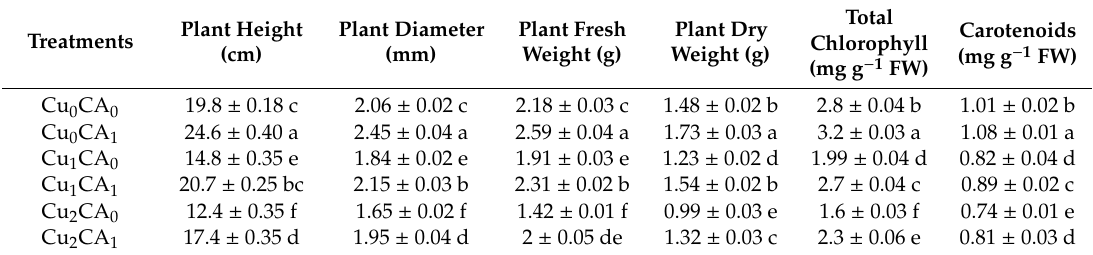
Table 1. E ff ect of citric acid (CA) application on plant growth, biomass and photosynthetic pigments of C. capsularis seedlings grown under di ff erent stress levels of Cu.